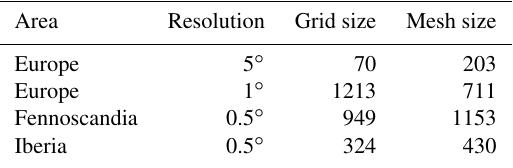
Table 1. Overview over the data resolution, the size of the spatial data grid and the mesh size for the four data sets analysed in this